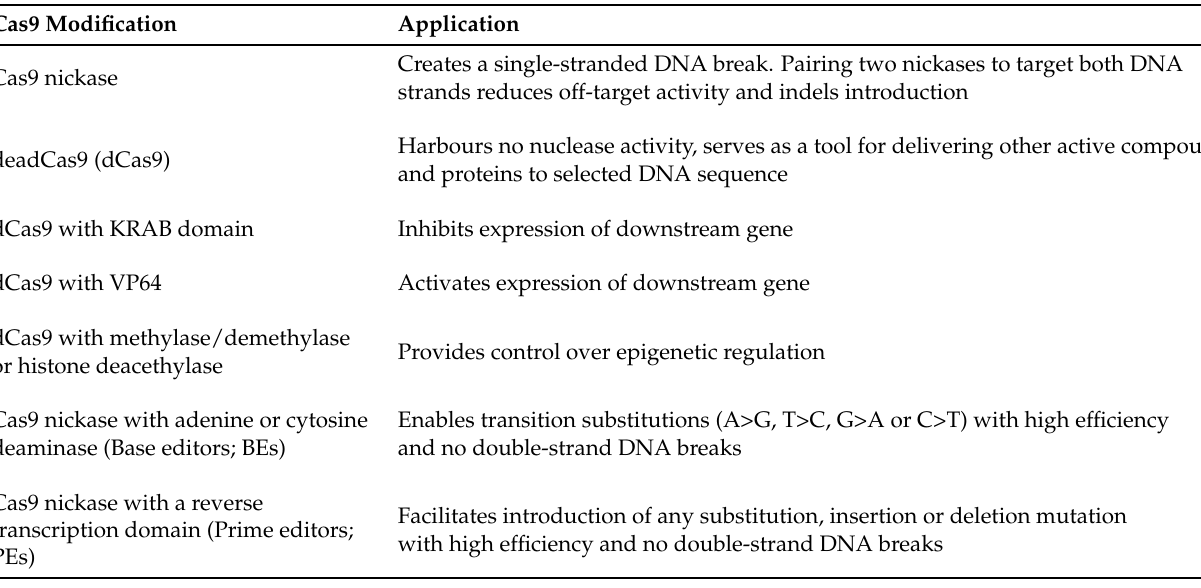
Table 1. Available modifications of Cas9 protein employed to alternatively affect recognised DNA sequence, without introduction of DSBs